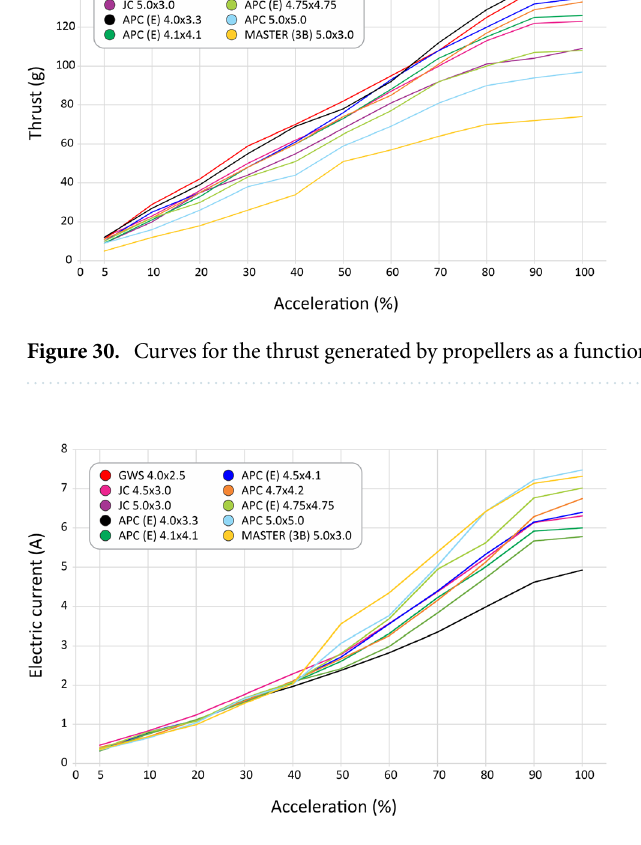
Figure 31. Curves of the electrical current consumed with the use of each propeller as a function of acceleration.